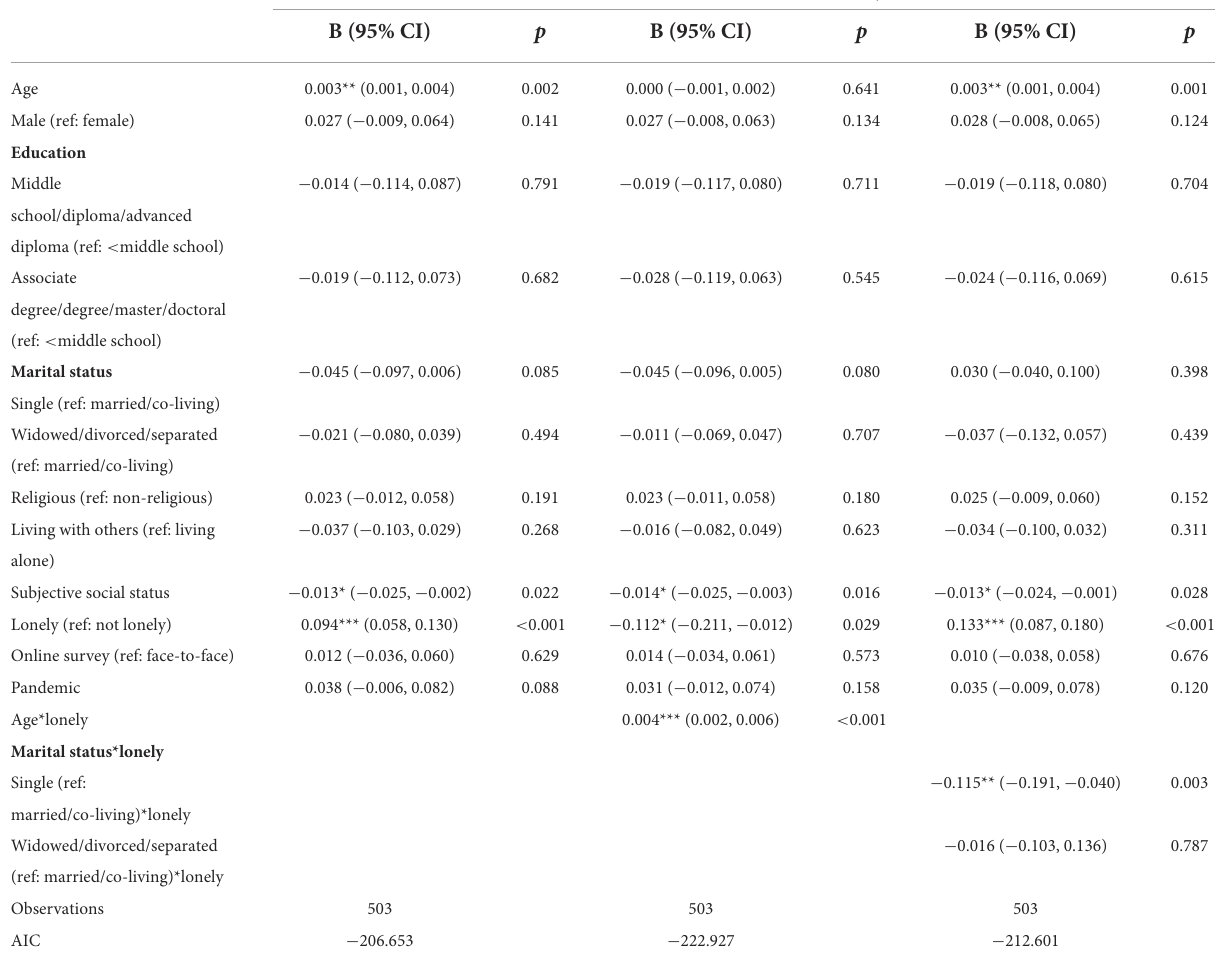
TABLE 5 Generalized linear models of factors associated with EQ-5D-5L HK index scores.